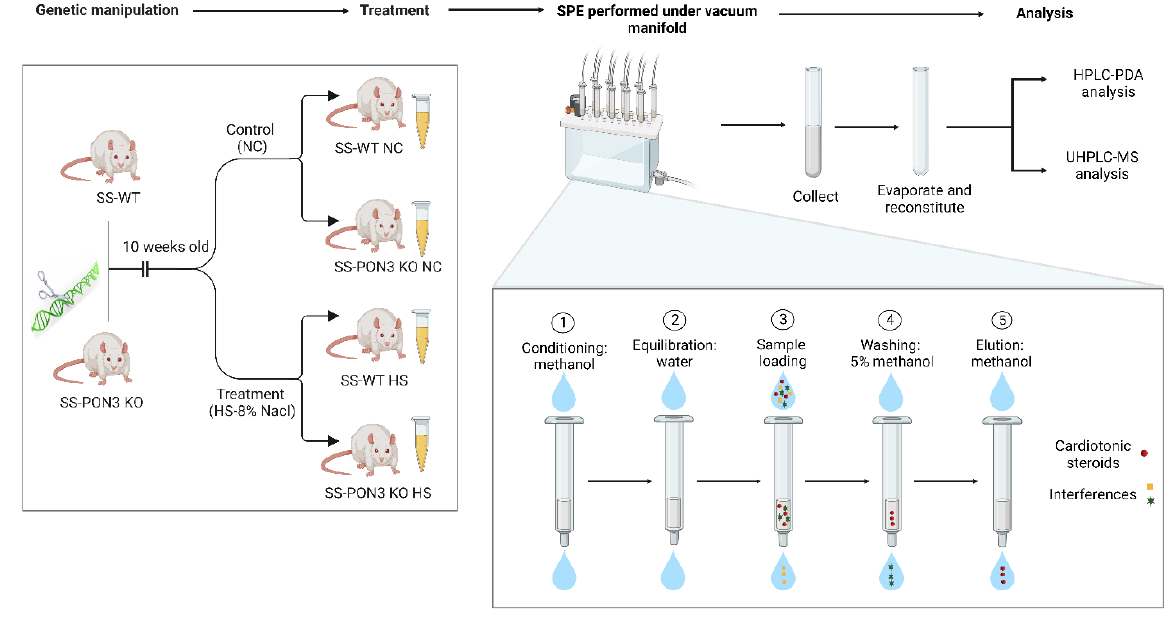
Figure 7. Animal treatment, urine collection and sample preparation using SPE before injection into the analytical instruments. (Created with BioRender.com) Date when last assessed: 16 September 2022.